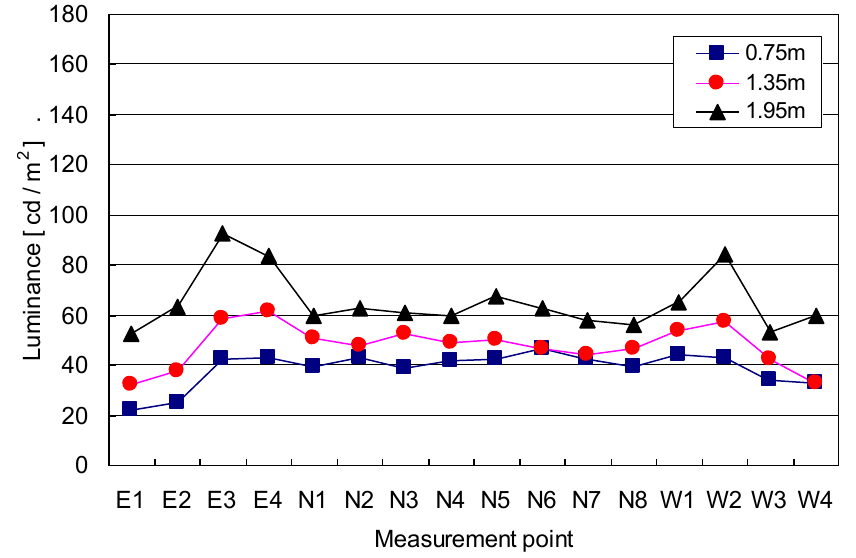
Figure 6. Variation of luminance on walls (500 lx